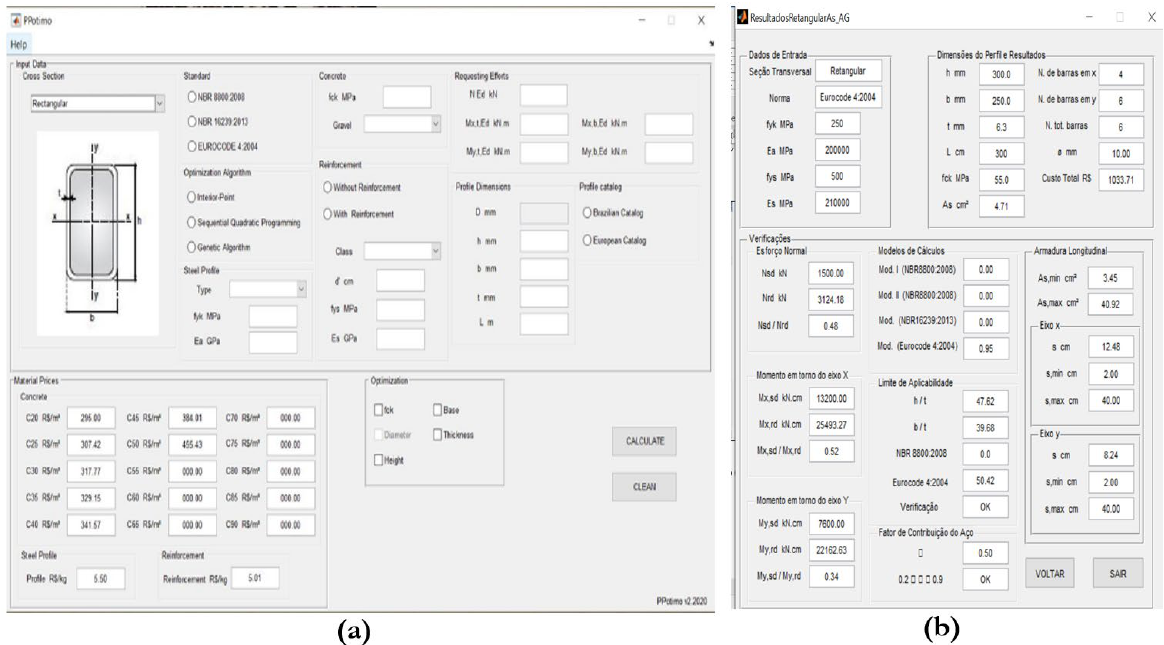
Figure 4. (a) Input screen of the developed software; (b) Output